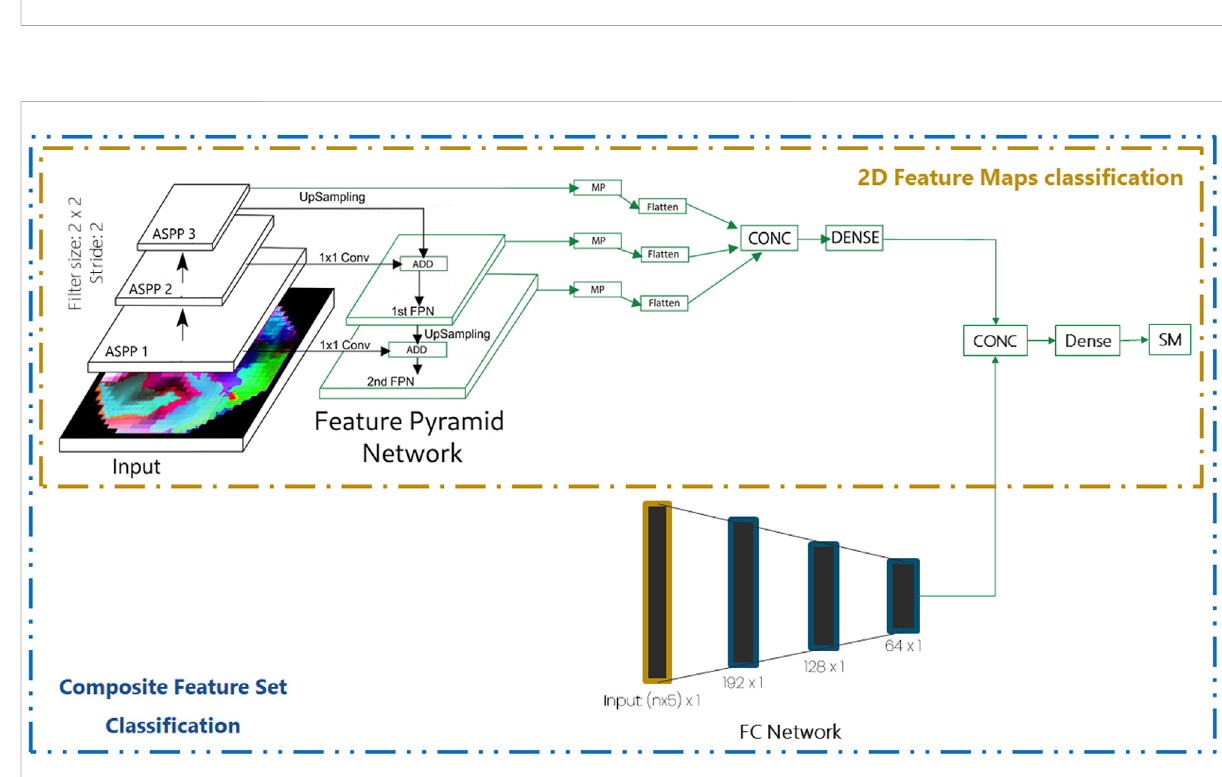
Frontiers in Signal